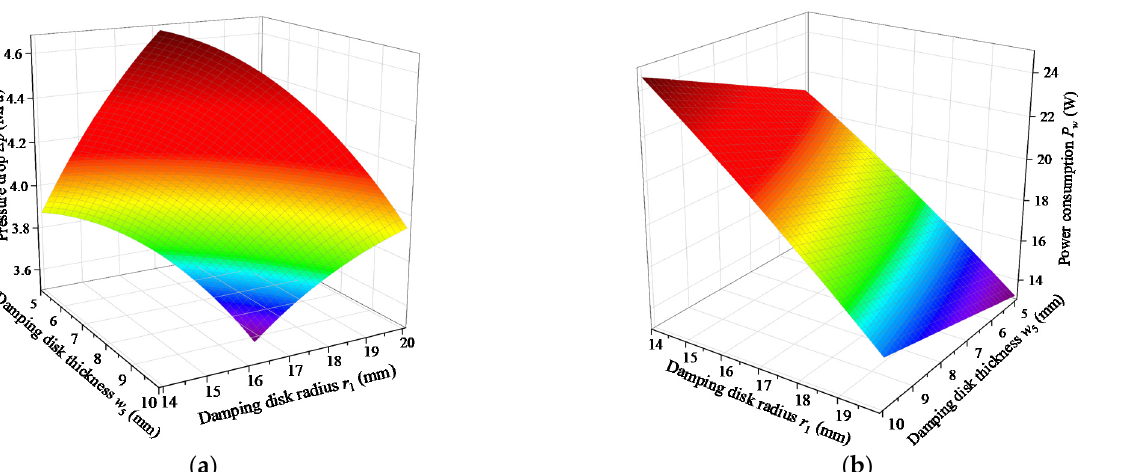
Figure 11. Fitting surface of model for g a = 1.25 mm, g r = 1.25 mm: ( a ) pressure drop Δ p , ( b ) power consumption P w.